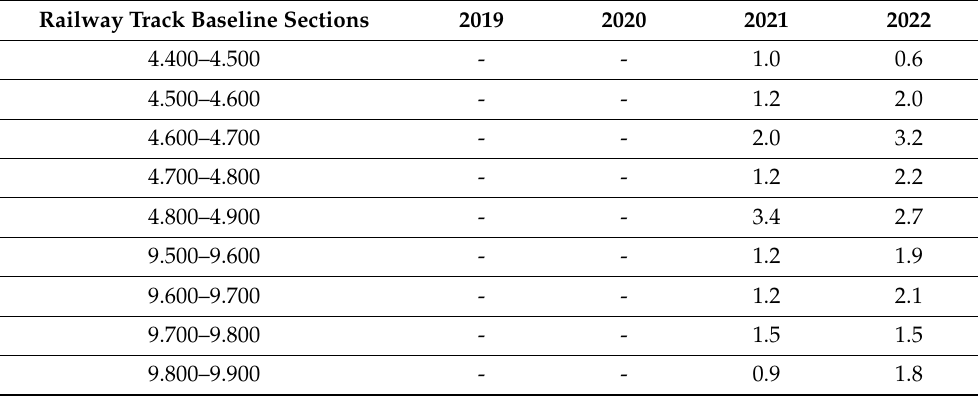
Table A4. Estimates of the railway track condition—absolute J , object No. R 161_1. Railway Track Baseline